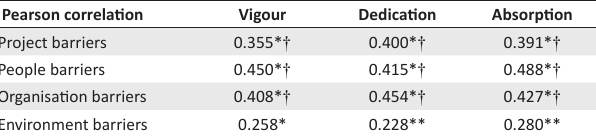
TABLE 4: Correlation coefficients between barriers to change dimensions and work engagement